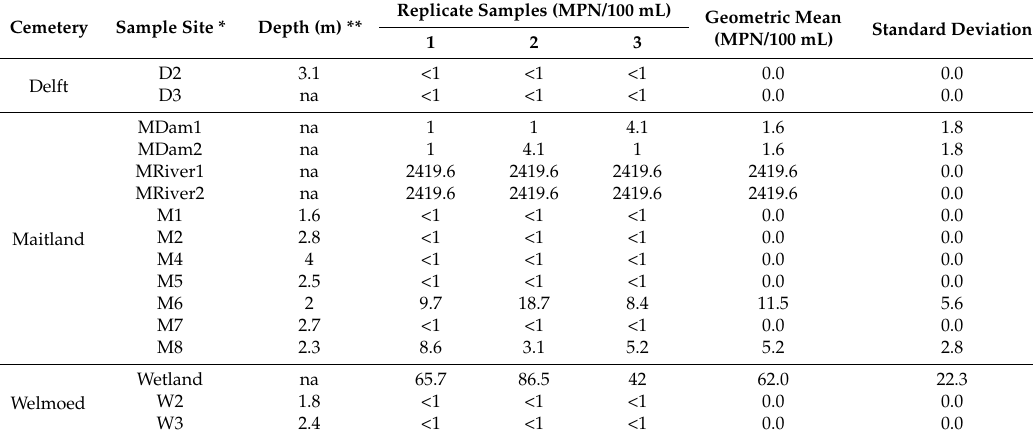
Table 1. Mean Escherichia coli count for water samples collected at three Cape Town cemeteries. Cemetery Sample Site * Depth (m) **